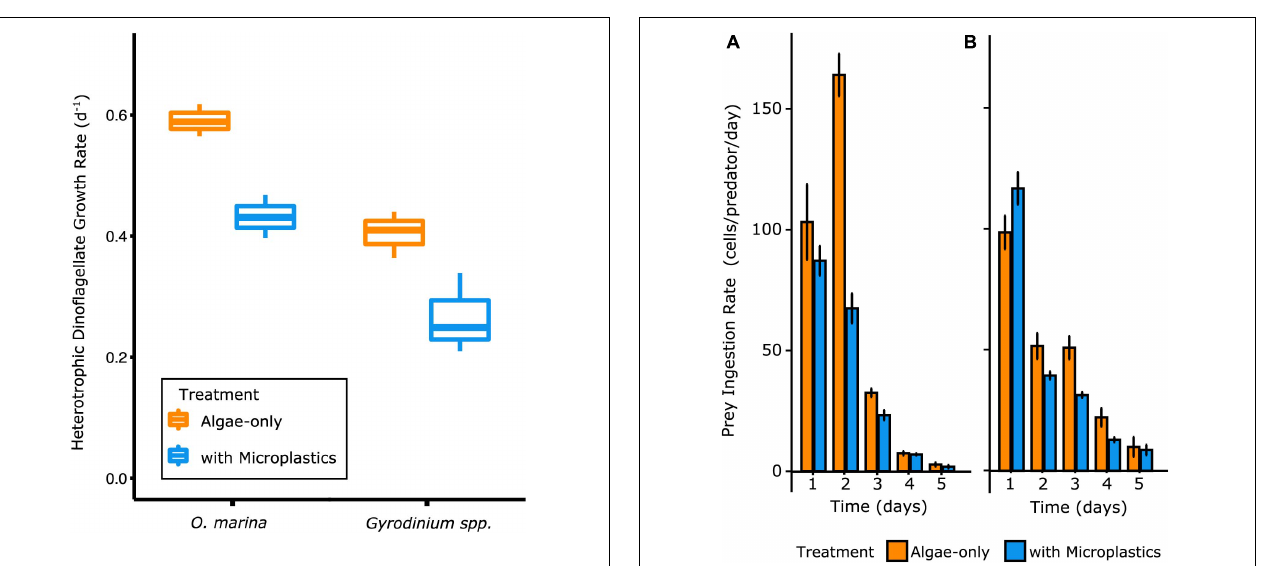
FIGURE 3 | Heterotrophic dinoflagellate growth rates during the exponential growth phase were higher when dinoflagellates were fed only algal prey (orange) and lower when fed a mixture of algal prey and microplastics (blue). The box plot shows median, the 25th–75th percentiles, and error bars as the 95% confidence interval.